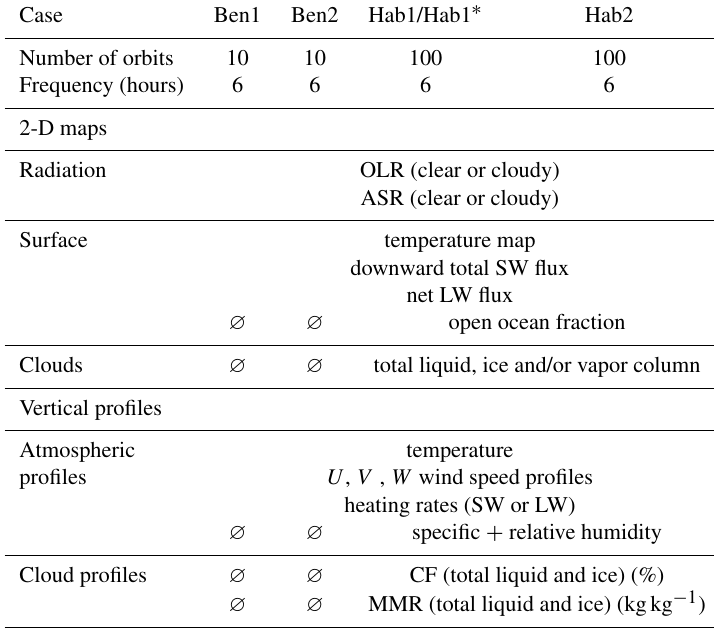
Table 3. Instantaneous fields to be output by the GCM. For each diagnostic, the mean value and the standard deviation are computed from data output at the specified frequency and number of orbits for the case. OLR and ASR correspond to outgoing longwave radiation (at TOA) and absorbed shortwave radiation (at TOA), respectively; SW and LW correspond to shortwave and longwave radiation, respectively; CF corresponds to cloud fraction and MMR corresponds to mass mixing ratio. The empty set symbol ( ∅ ) represents parameters that are not relevant for a specific case. Case Ben1 Ben2 Hab1/Hab1